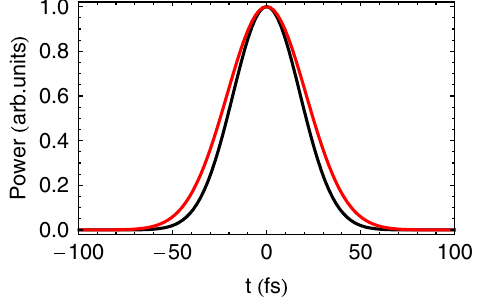
FIG. 6. Spectral bandwidth in 7.5 mm gain length of BBO OPCPA pumped by 800 nm pulses at 10 GW = cm 2 , at noncol- linear angles of: 0 (cid:6) -black, 2 (cid:6) -red, 3 (cid:6) -green, 4 (cid:6) -blue, 5 (cid:6) -brown.